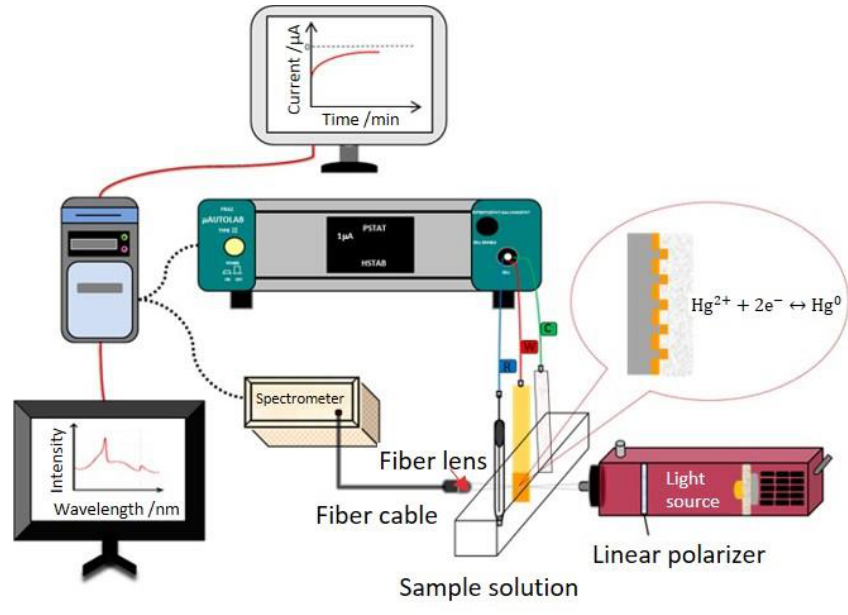
Figure 2. Schematic representation of the EC-SPR system for mercury ion detection. The transmission SPR spectra were measured by a simple optical setup (Figure